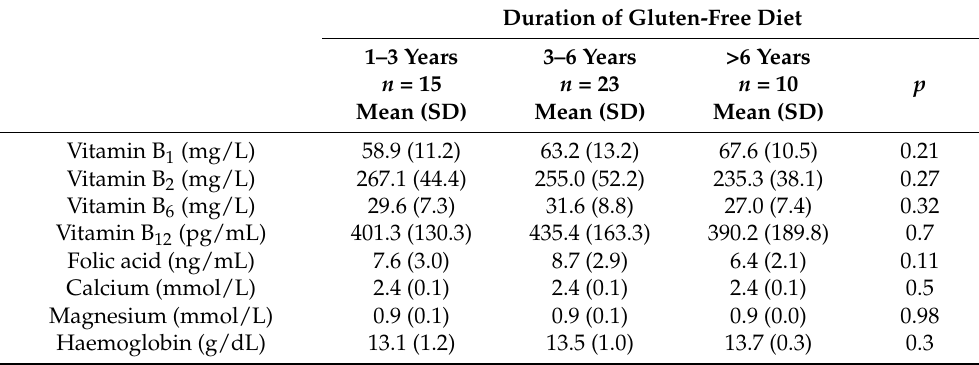
Table 5. Mean haemoglobin level and serum values of selected micronutrients in CD children with regard to GFD duration.